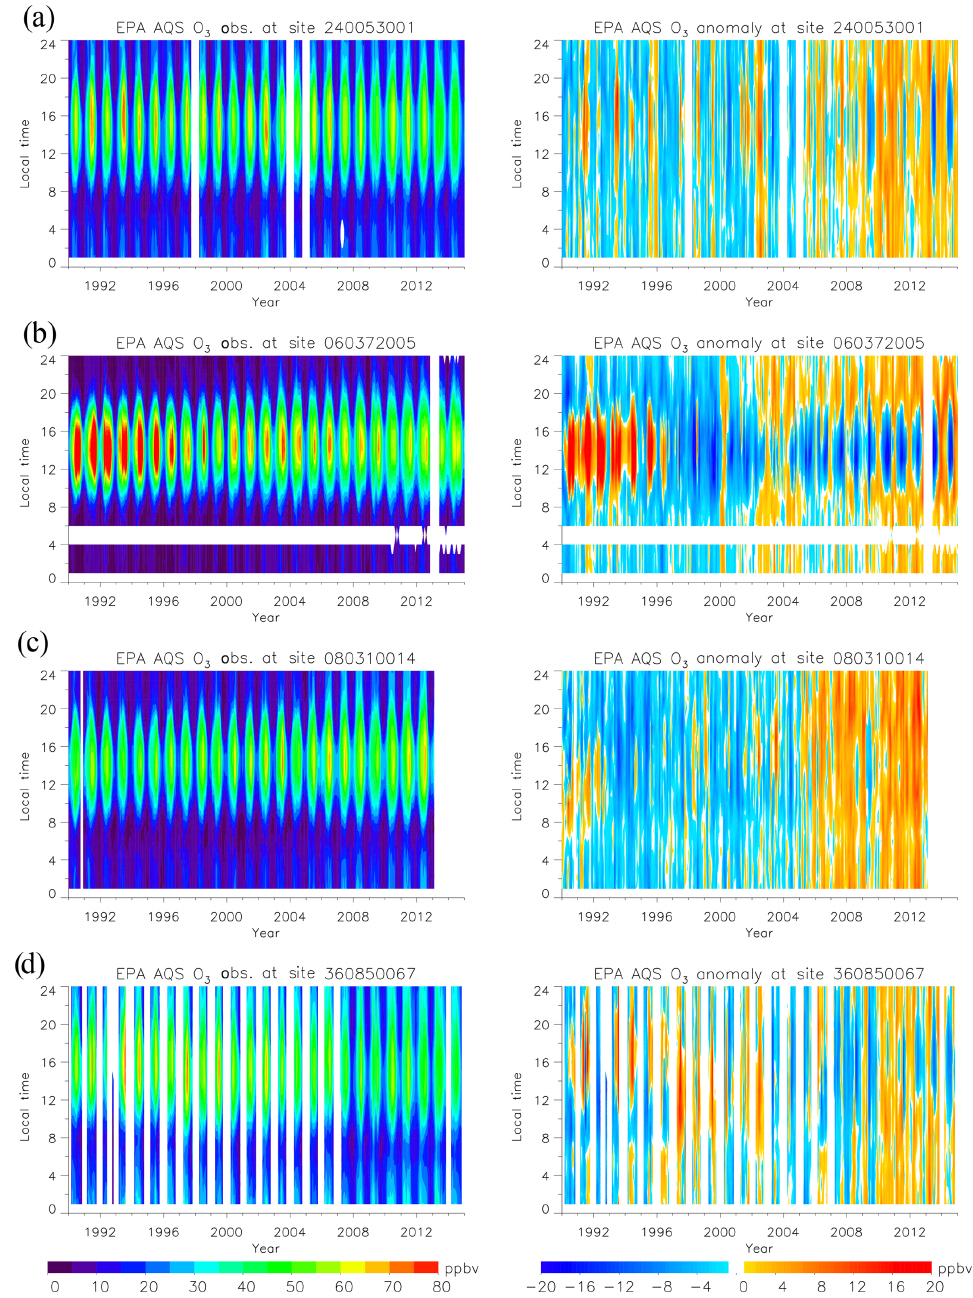
Figure 6. The box-averaging analyses of AQS ozone observations at selected sites from 1990 to 2015. (a) Essex, Maryland (suburban Baltimore; AQS ID 240053001); (b) Pasadena, California (downtown Los Angeles; AQS ID 060372005); (c) Denver, Colorado (downtown Denver; AQS ID 080310014); (d) Staten Island, New York (suburban New York City; AQS ID 360850067). Left column shows the monthly mean, and right column shows the anomaly values. White patches stand for missing data or not sufficient data for the box-averaging